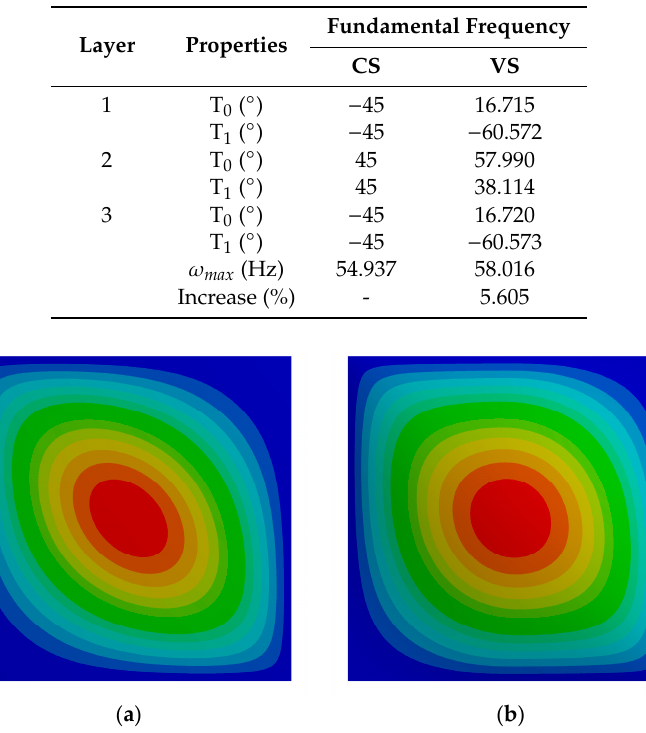
Table 20. Optimal angles of a three-layer VS plate for static buckling load multipliers. Laye r